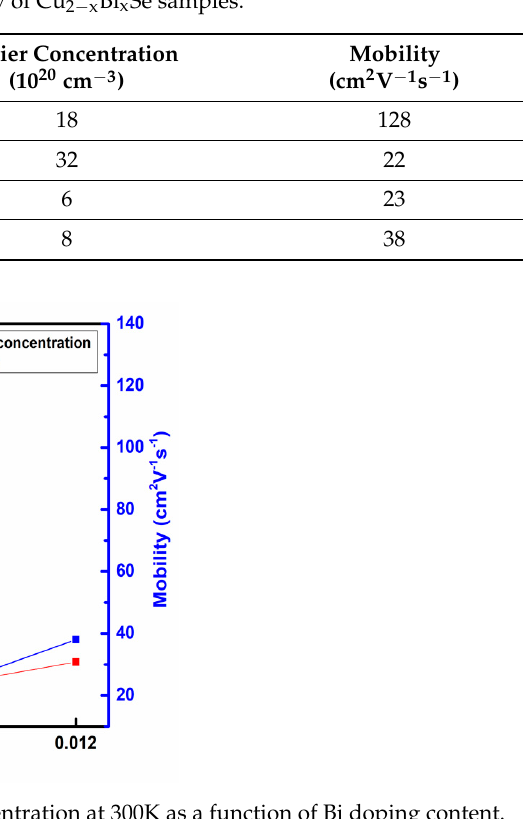
Figure 7. Plot of mobility and carrier concentration at 300K as a function of Bi doping